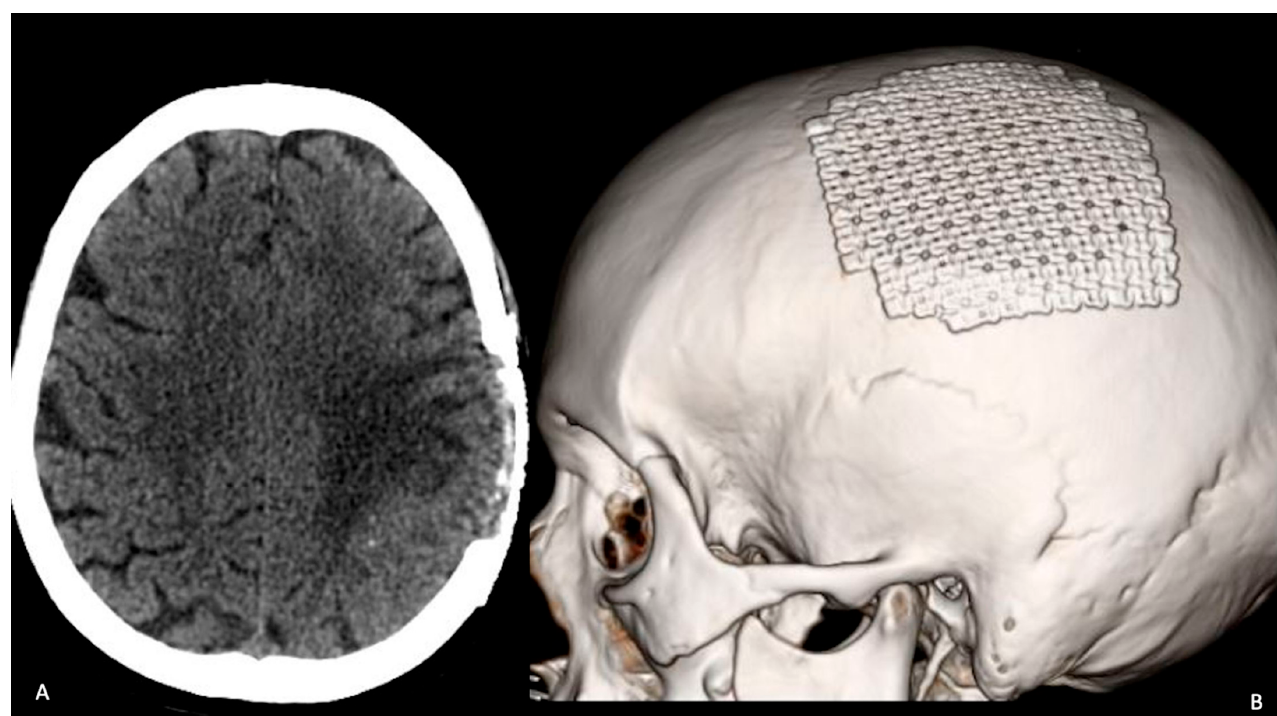
Figure 4. ( A ). CT axial scan performed 30 days after surgery showing good radiological outcome. ( B ). 3D detail of the mesh used for skull reconstruction.